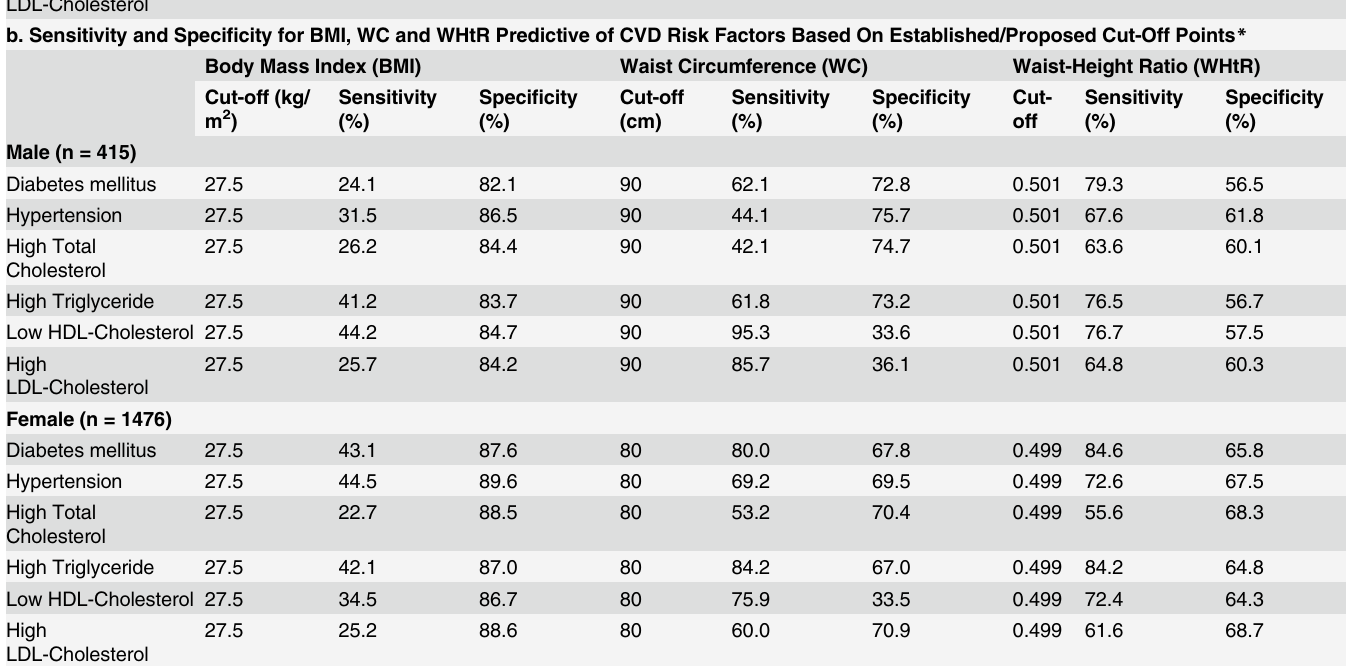
* BMI (cid:1) 27.5 kg/m 2 (High Risk Category, Obesity equivalent for Asians) WC (cid:1) 80cm for females, WC (cid:1) 90cm for males (Asian Cut-Offs); WHtR (cid:1) 0.5 (Proposed Cut